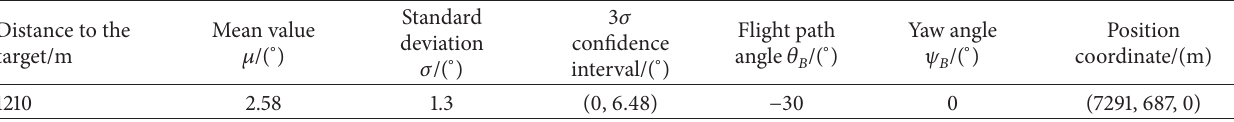
Table 3: The end point of midcourse guidance.